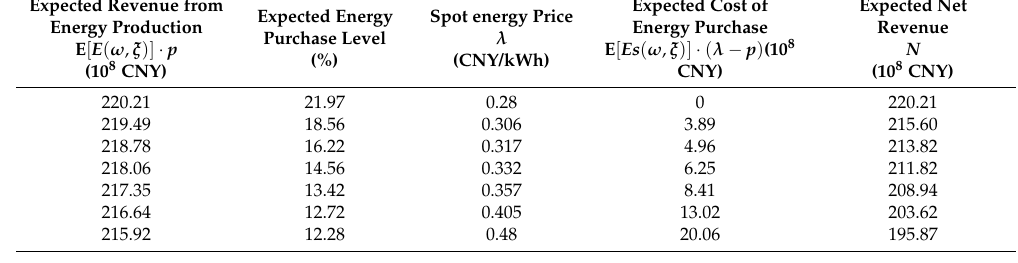
Table 3. Optimal model results under different values of λ .